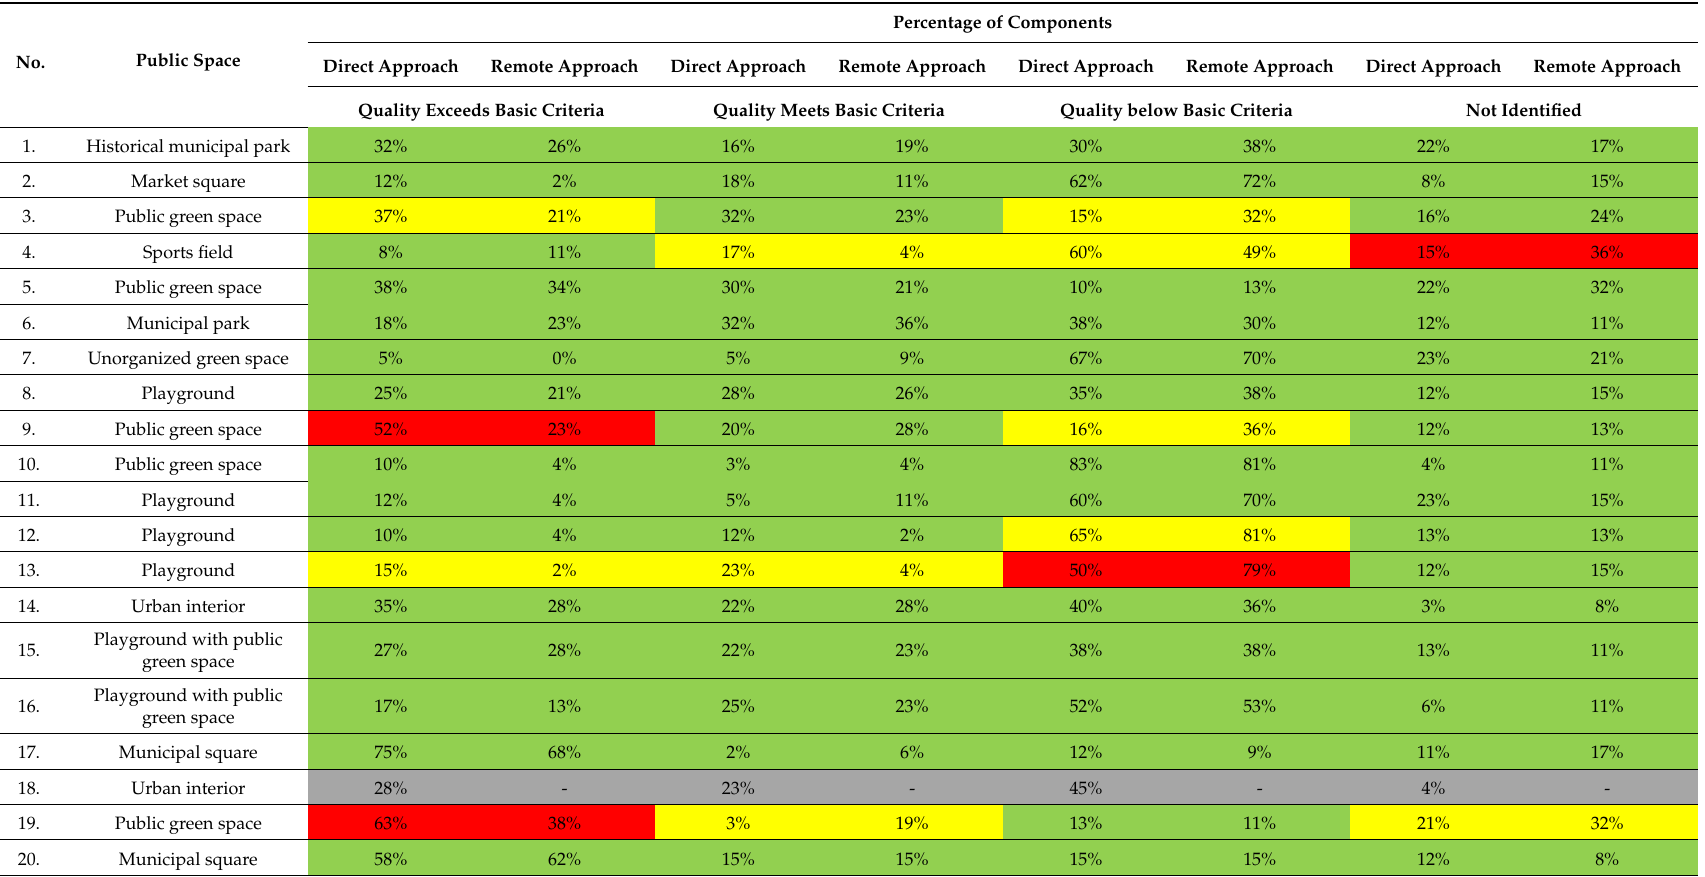
Table 3. An evaluation of the quality of public spaces—a comparison of the results of direct and remote analyses for Mor ˛ag. Source: own